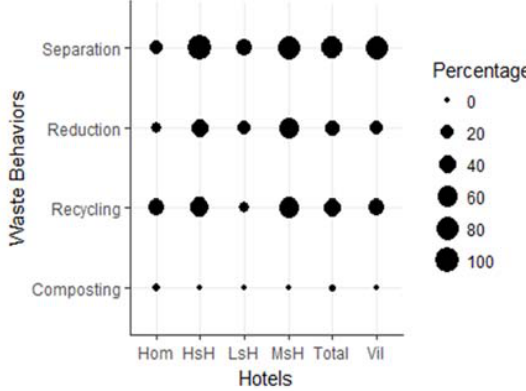
Fig. 7: The status of waste management practices